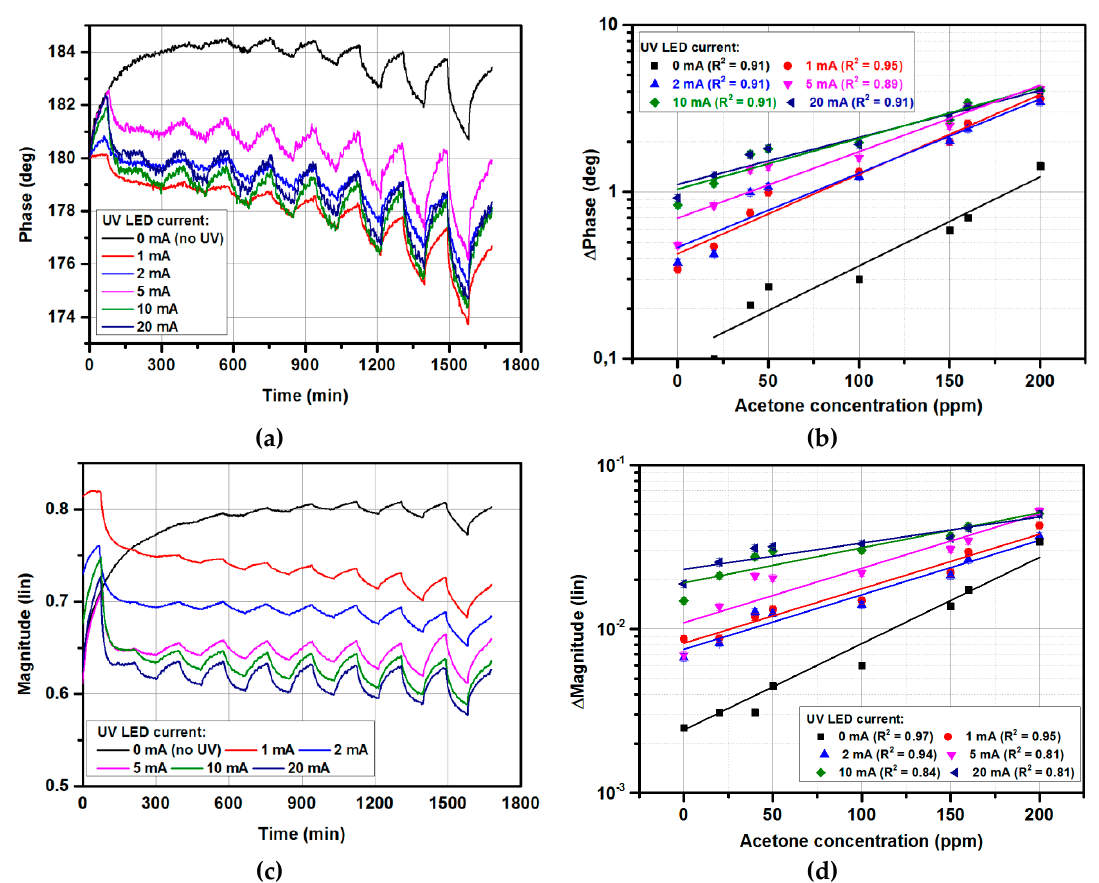
Figure 3. The gas-sensing characteristics under exposure to acetone in the 0–200 ppm range: ( a ) phase changes in time domain; ( b ) calibration curve of phase changes; ( c ) magnitude changes in time domain; ( d ) calibration curve of magnitude changes.